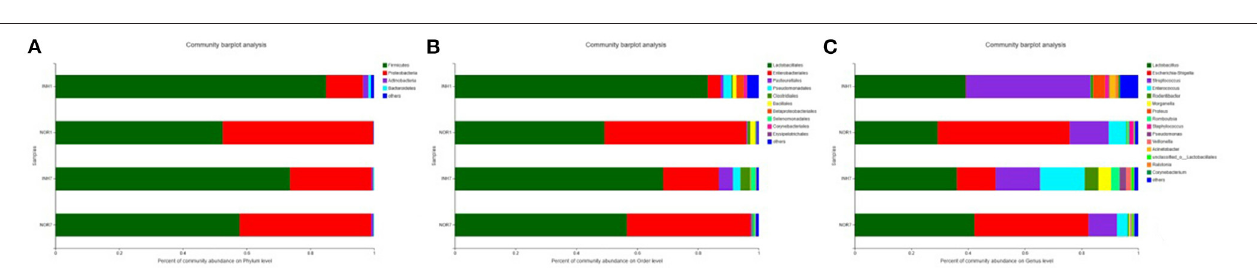
FIGURE 3 | Alpha diversity index test results. NOR1 vs. INH1: * P < 0.05; INH1 vs. INH7: 1 P < 0.05.